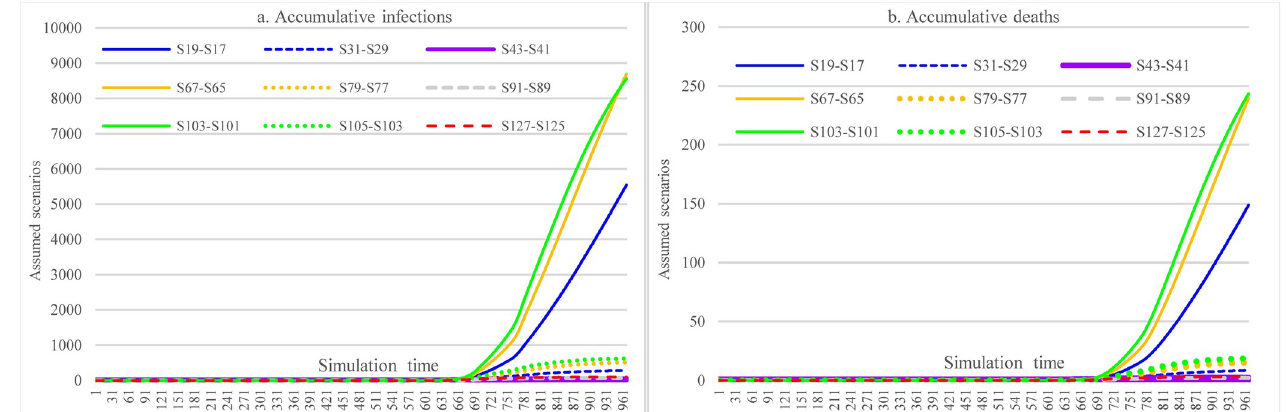
Fig 12. Impacts of the immunological period on COVID-19 considering mask-wearing adherence and increasing vaccination capacity.